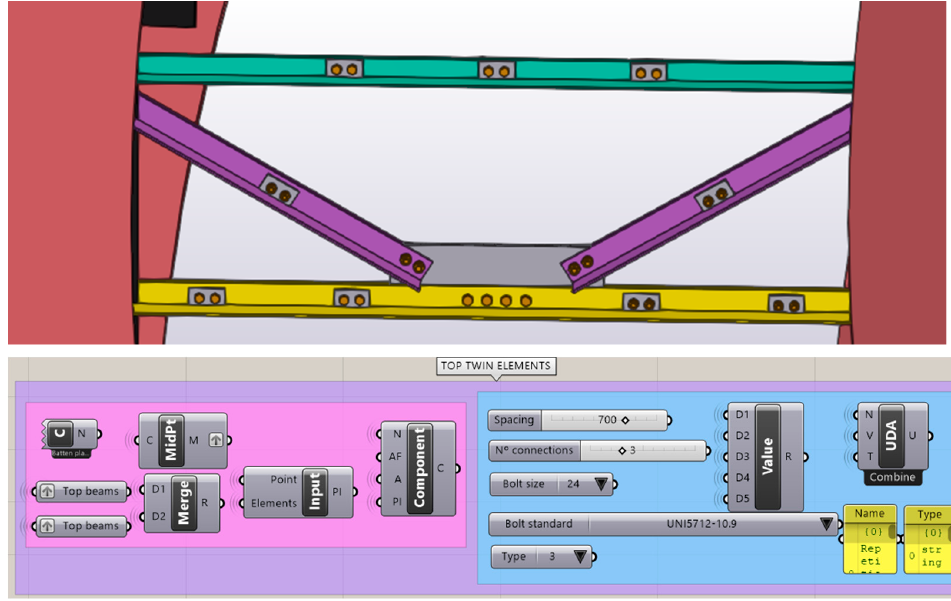
Figure 8. Twin elements connection—visual script example for live model transfers from Grasshopper to Tekla Structures.